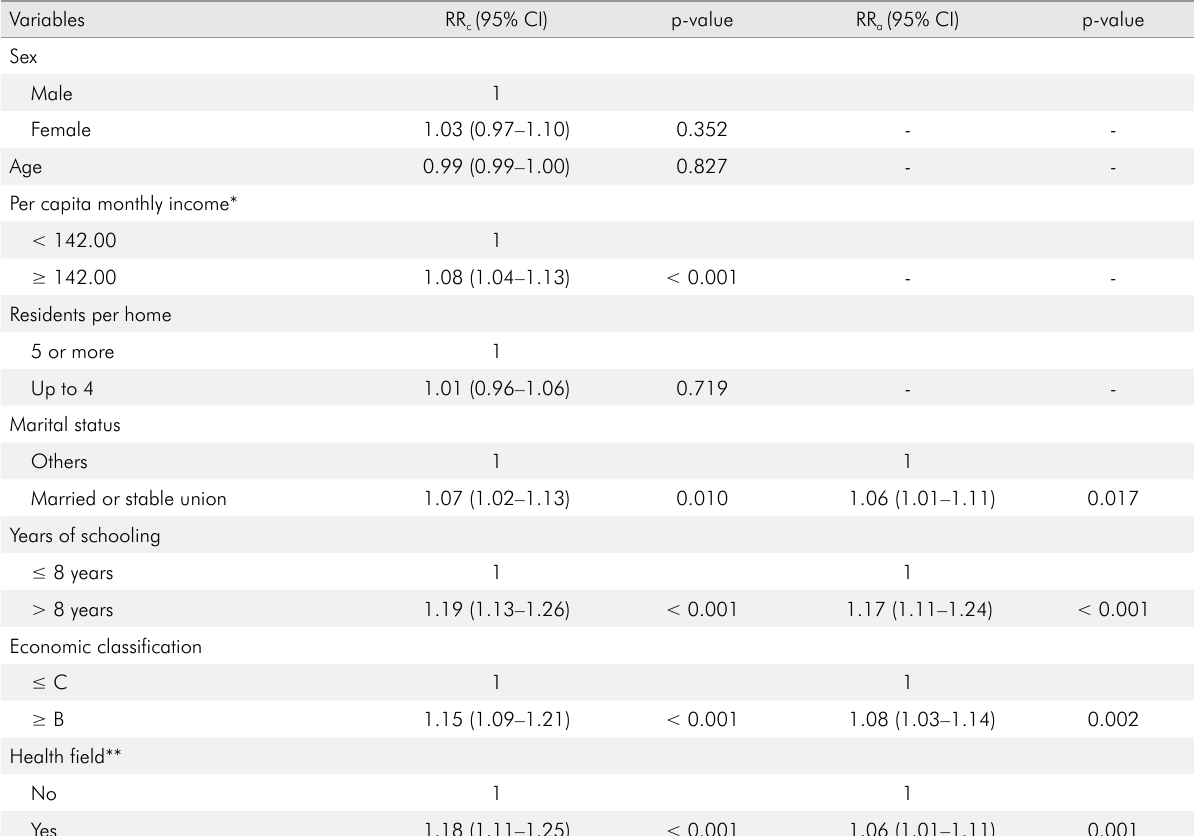
Table 2. Univariate and Poisson regression multivariate models of for association between BREALD-30 score and the variables of interest (Curitiba, Brazil,